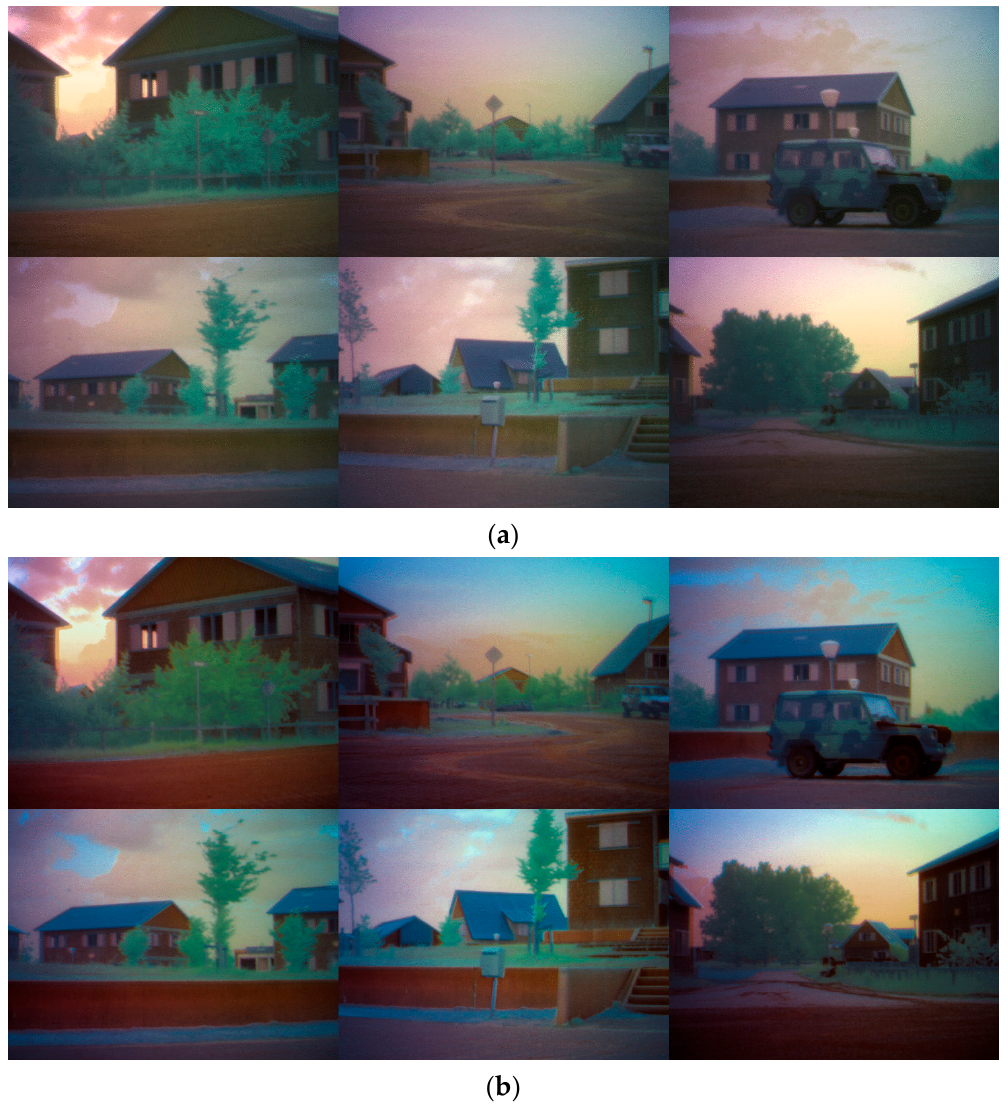
Figure 10. Results from ( a ) the SCF method and ( b ) rigid-3D-fit (R3DF) method. The training and test sets were the same in these cases.